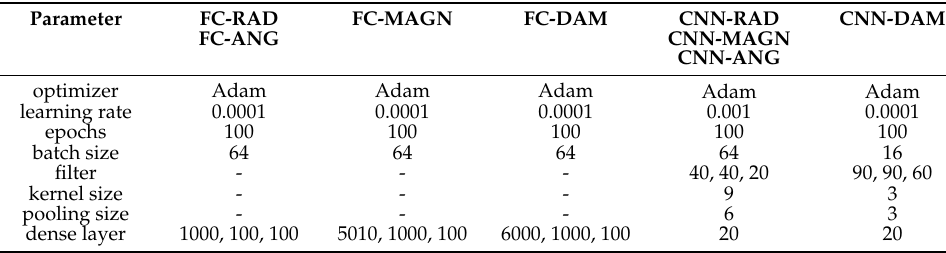
Table 2. Hyperparameters used for the networks FC and CNN depending on the four classifiers RAD, ANG, MAGN and DAM.